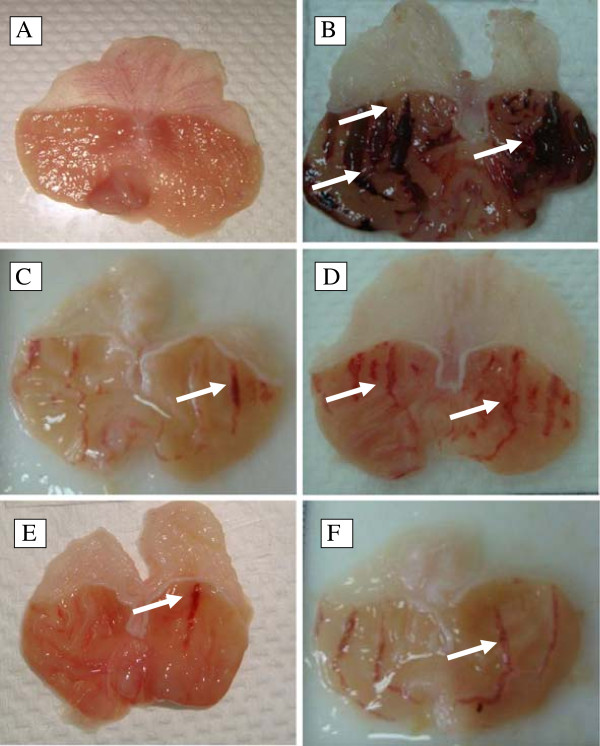
Gross evaluation. Macroscopic appearance of the gastric mucosa of the rats pre-treated with DES at doses 5, 10, 20 mg/kg (D,E, F) or omeprazole 20 mg/kg (C) showed reduced lesion formation when compared to the ulcer control rats (B) 2C. Ethanol-induced sever injuries to the gastric mucosa appear as elongated bands of haemorrhage (white arrow). (A) Showed normal macroscopic appearance of the intact stomach from normal group. (magnification: 1.8×).